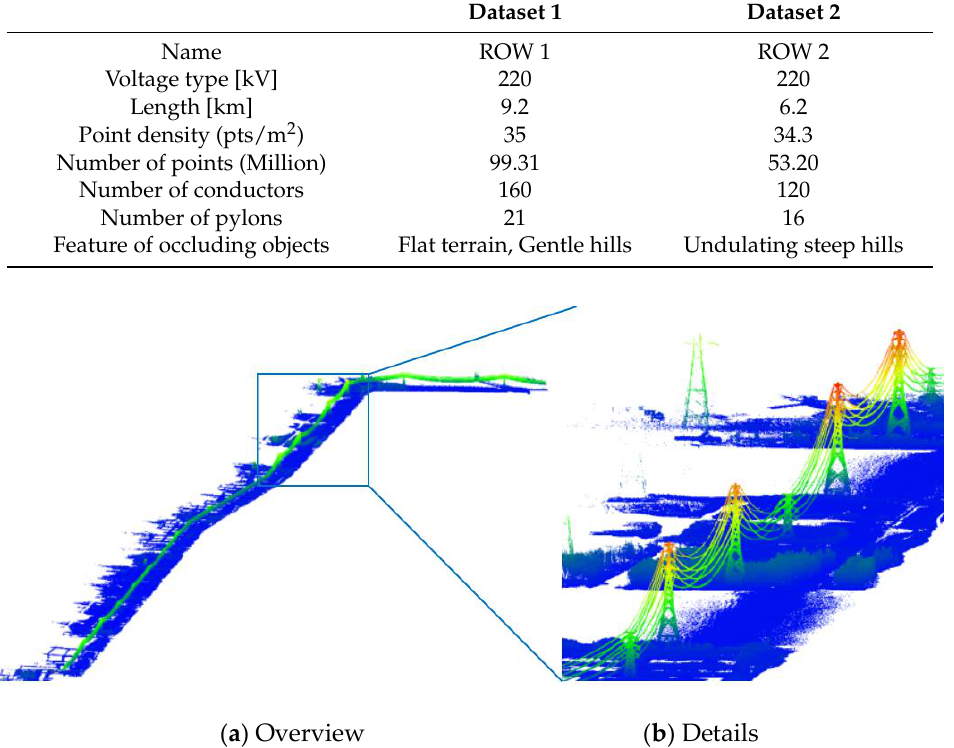
Table 3. Experiment dataset description.